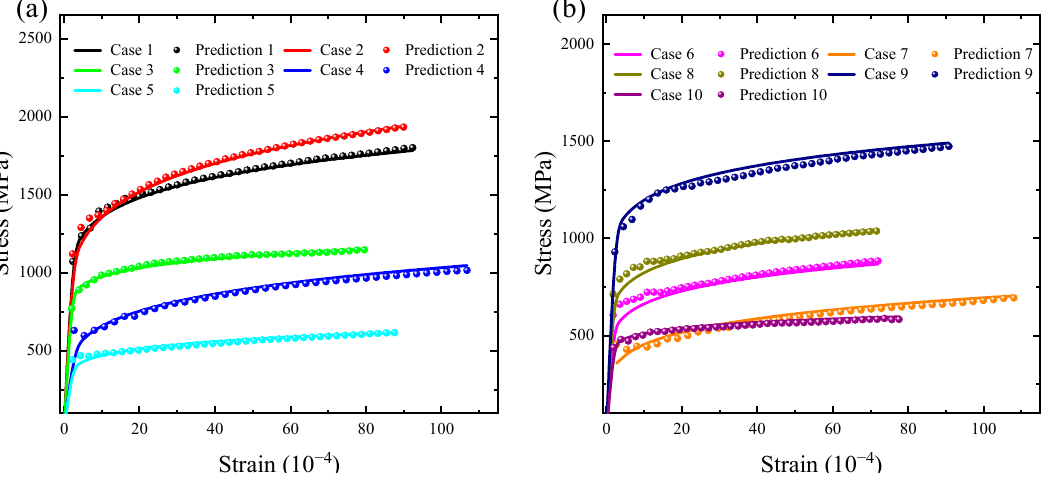
Figure 7. The prediction performance of the LSTM neural network is demonstrated. ( a ) indicates the prediction effect of the LSTM neural network on 40 sets of sample data, and the predicted stress values are concentrated on the diagonal line of figure. ( a , b ) shows the MAPE distribution of each sample.